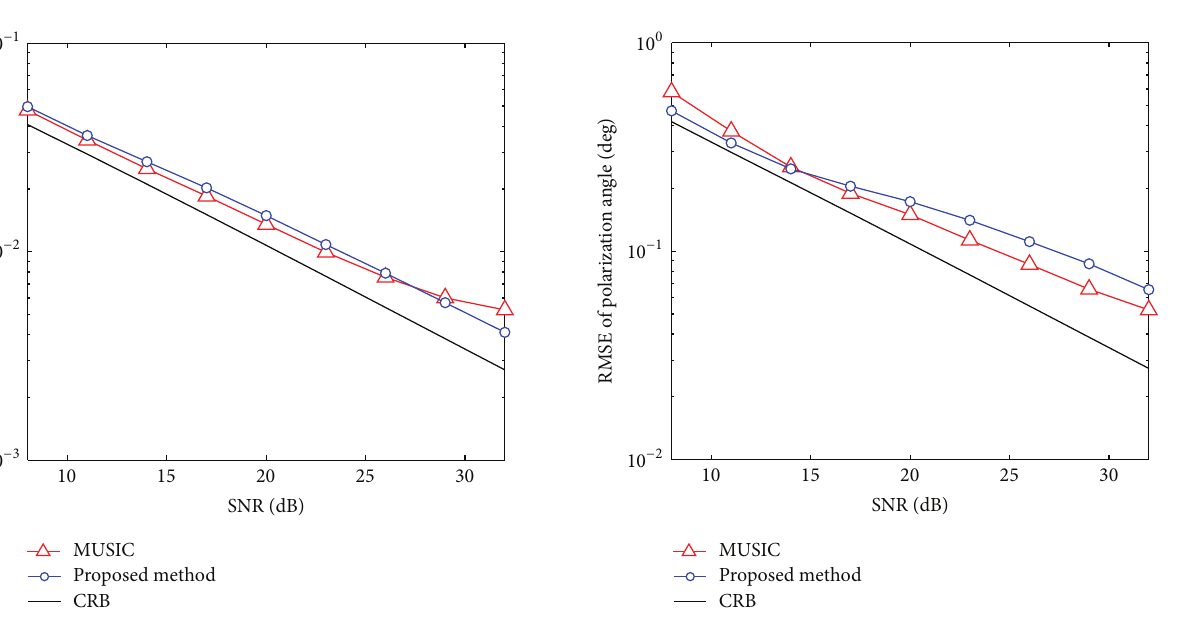
Figure 10: RMSE of the polarization angle for the weak source versustheSNRoftheweaksource,wherethestrongsourceislocated at (𝜃 1 ,𝛾 1 ) = (3 ∘ ,30 ∘ ) with SWR = 20 dB and the weak source is located at (𝜃 2 ,𝛾 2 ) = (7 ∘ ,35 ∘ )